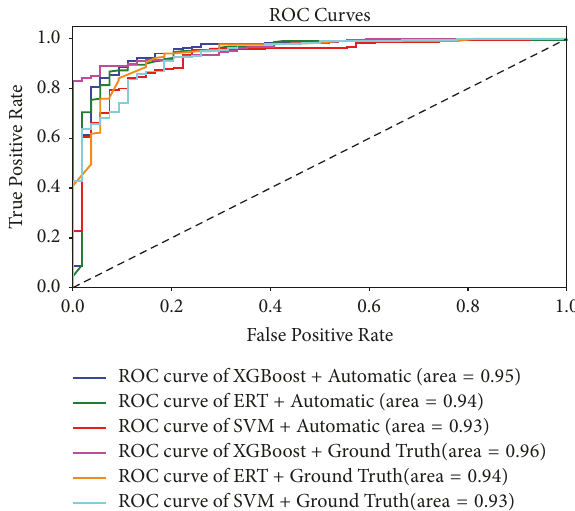
Figure 5: Receiver operating characteristic